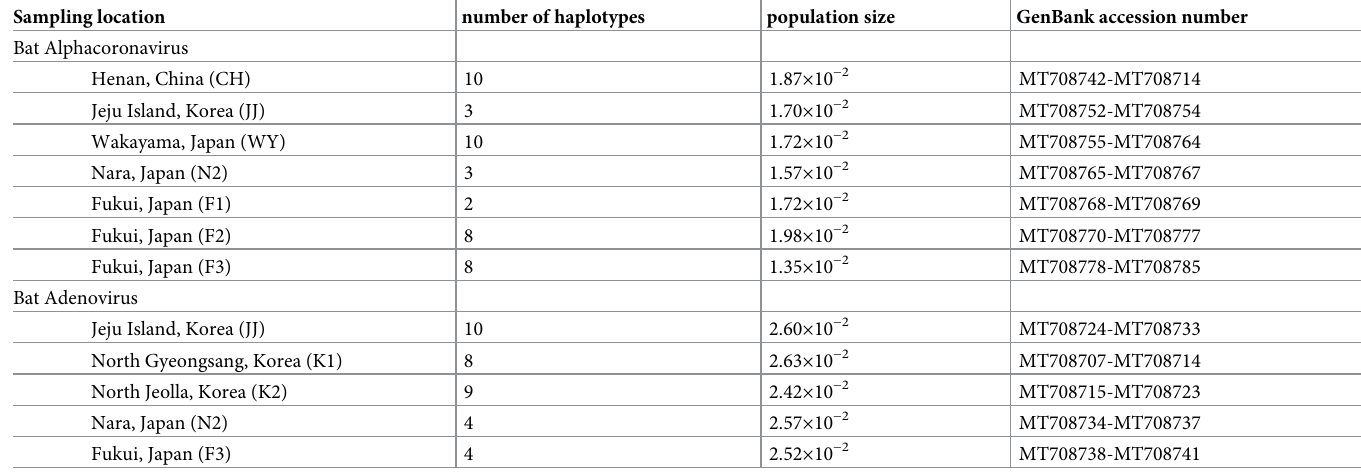
Table 2. Population size estimated using migrate-n analysis, number of haplotypes and GenBank accession numbers of bat alphacoronavirus and bat adenovirus. Sampling